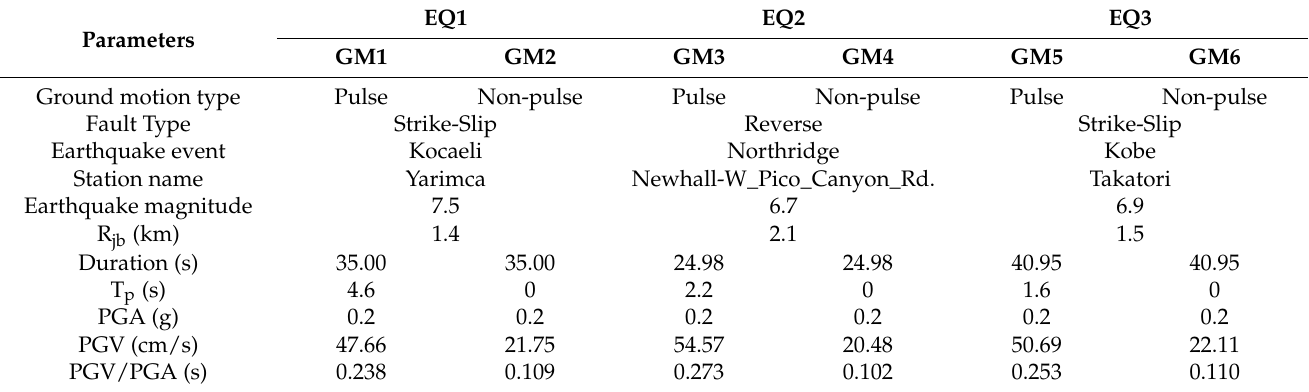
Table 3. Characteristic parameters of pulse and non-pulse type ground